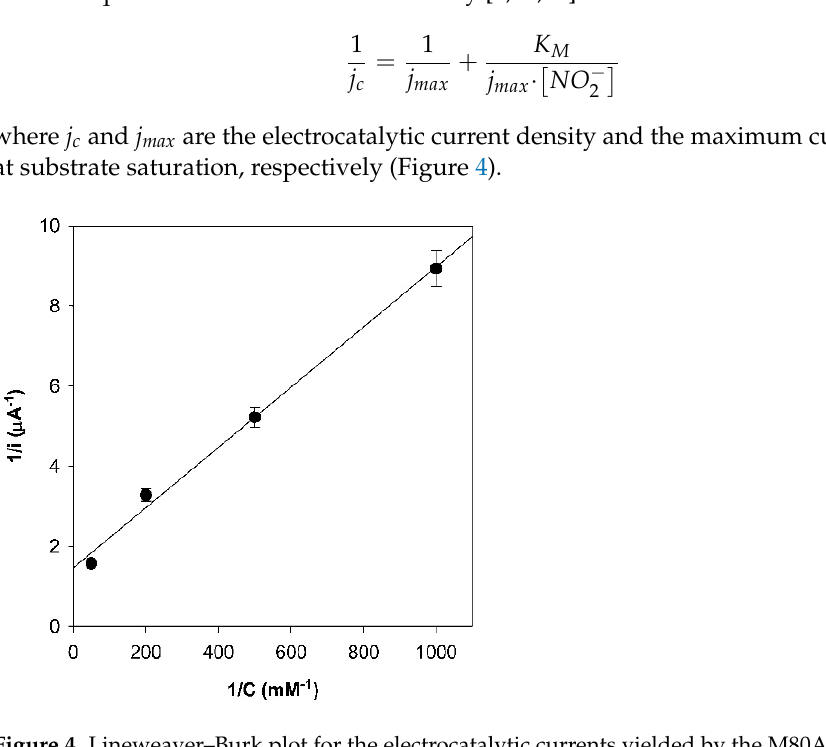
Figure 4. Lineweaver–Burk plot for the electrocatalytic currents yielded by the M80A/N62C/C102T variant of yeast iso-1-cytochrome c covalently linked to the electrode through an Au-S(Cys) bond, pH 7, in the presence of increasing nitrite ion concentrations. Reprinted with permission from ref. [8]. Copyright 2008 American Chemical Society.